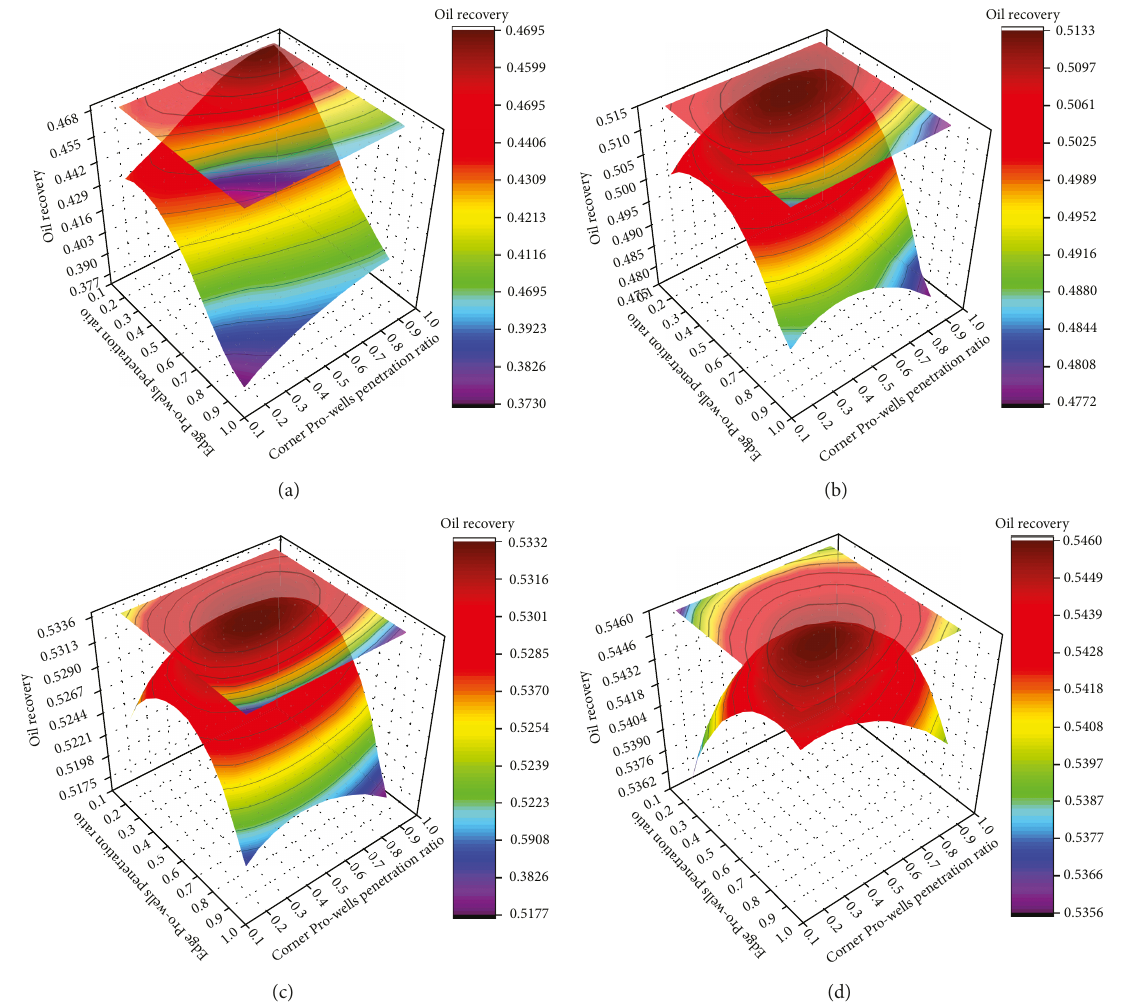
: k is 1 :1; (b) x y : k is 10 x y